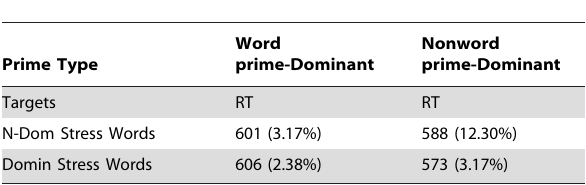
Table 4. Mean correct naming times and stress error percen- tage (in parentheses) for low frequency word targets with non-dominant and dominant stress, primed by words with non-dominant stress (ND) and nonwords in Experiment 2.